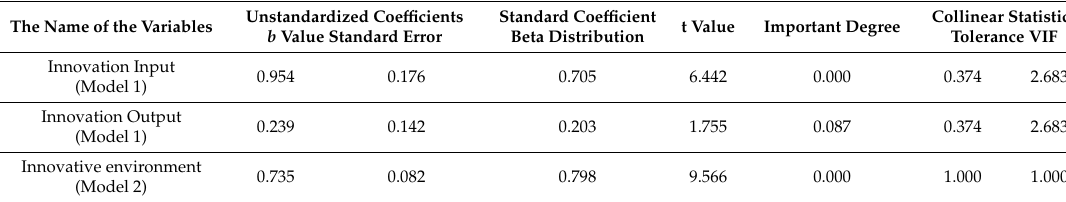
Table 5. Model coe ffi